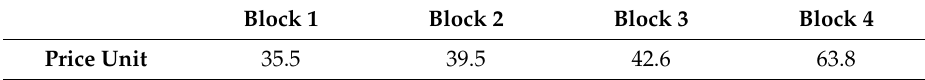
Table 5. Price of each block of the self-generation unit ( € /